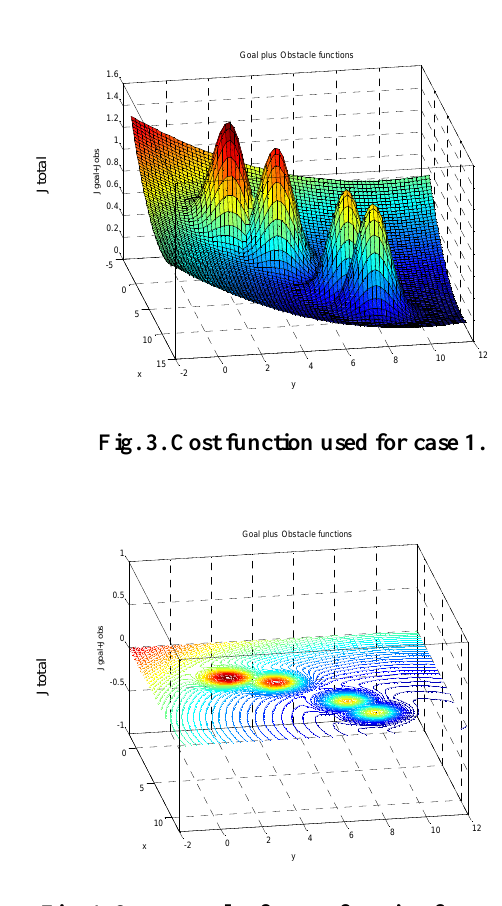
Fig. 4. Contour plot forcost function for case 1.